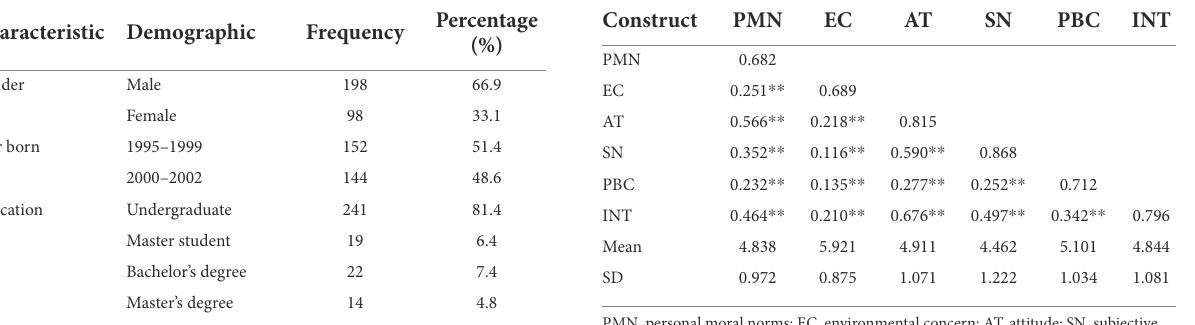
TABLE 3 Fornell-Larcker discriminant validity